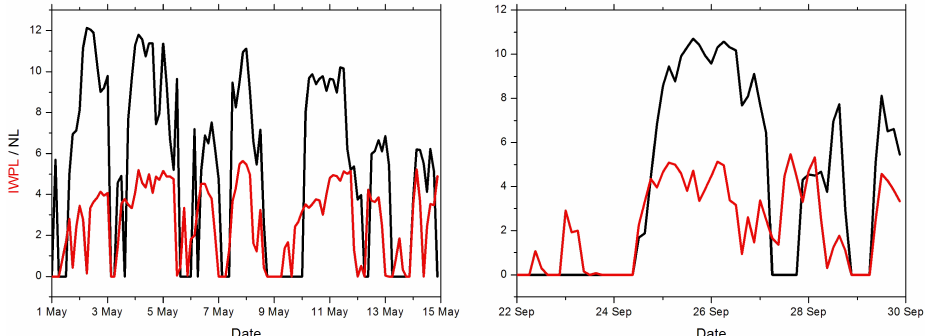
Figure 5. Time evolution of IWPL and NL over the periods 1–15 May 2010 (left) and 22–30 September 2012 (right).